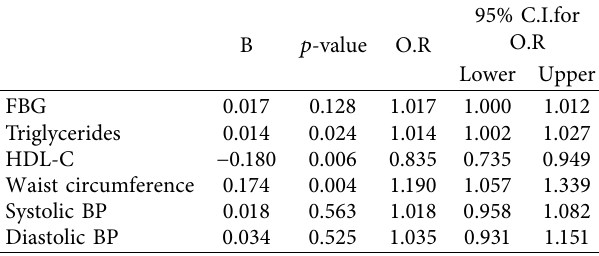
Table 3: The effect of metabolic syndrome parameters on